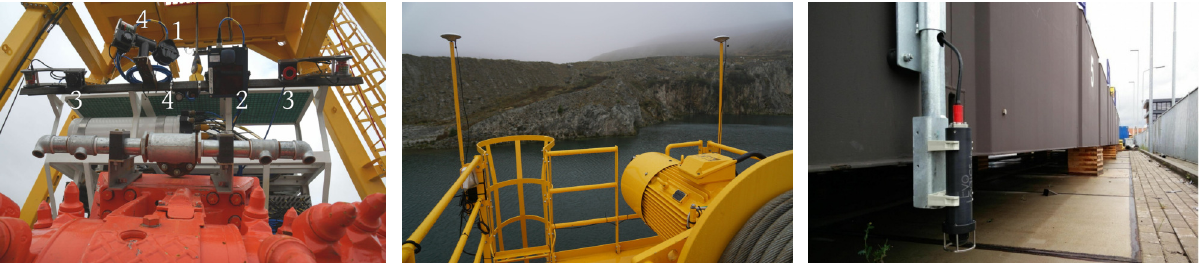
Figure 3. Perception and positioning sensors. Left: perception sensors mounted to the sensor bar on the front of the mining vehicle, middle: GNSS antennas mounted on the top of the launch and recover vessel, right: SBL acoustic transponder mounted on the corners of the vessel for underwater positioning.